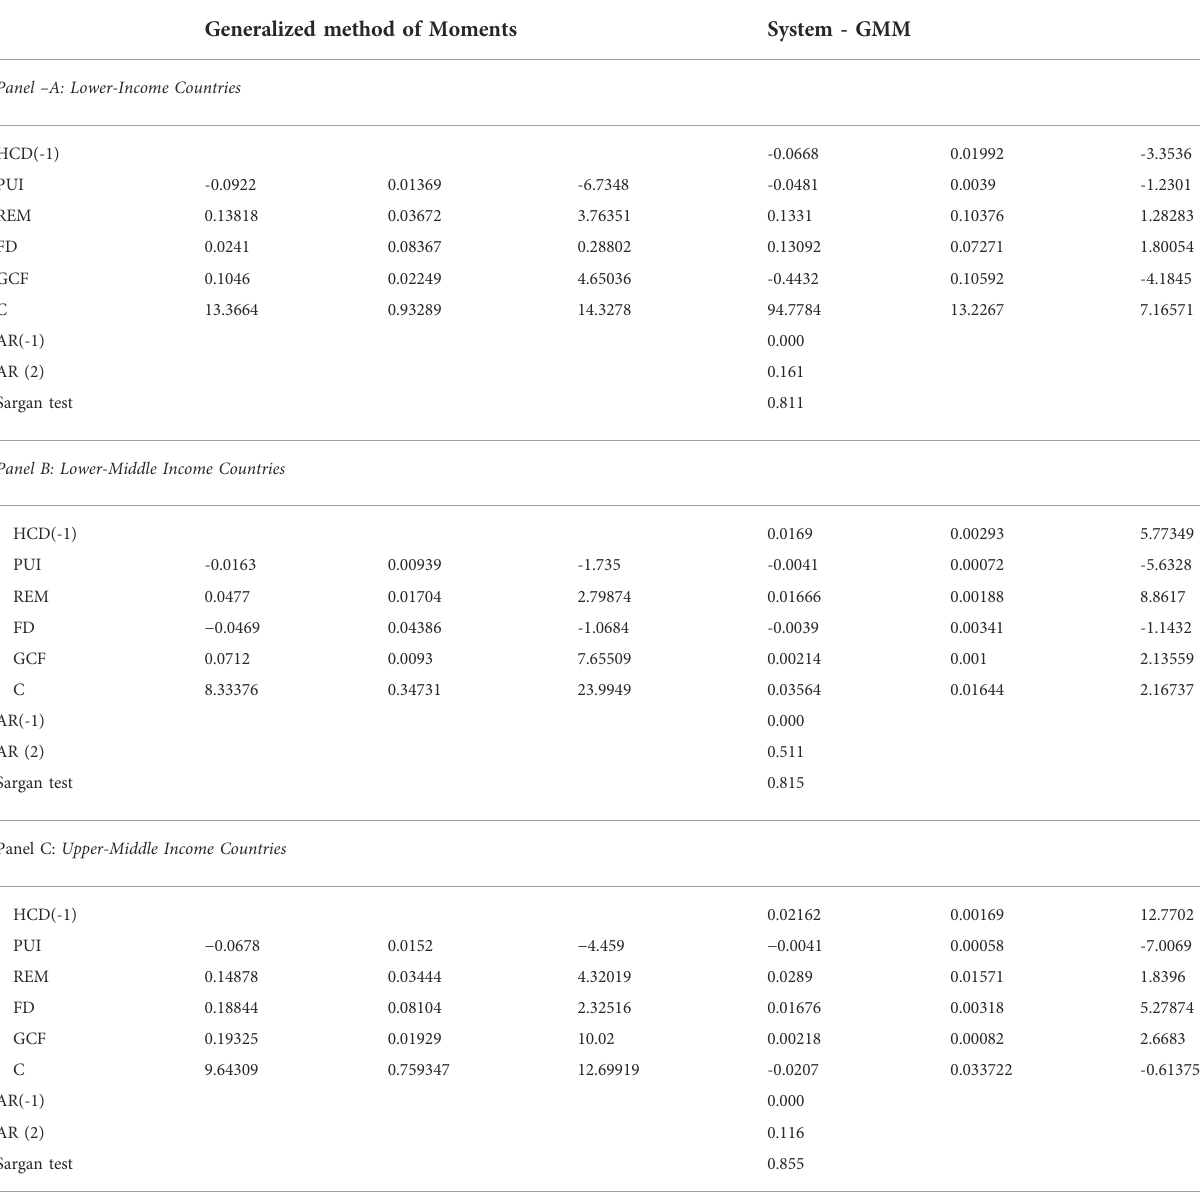
TABLE 7 Robustness test: GMM and System